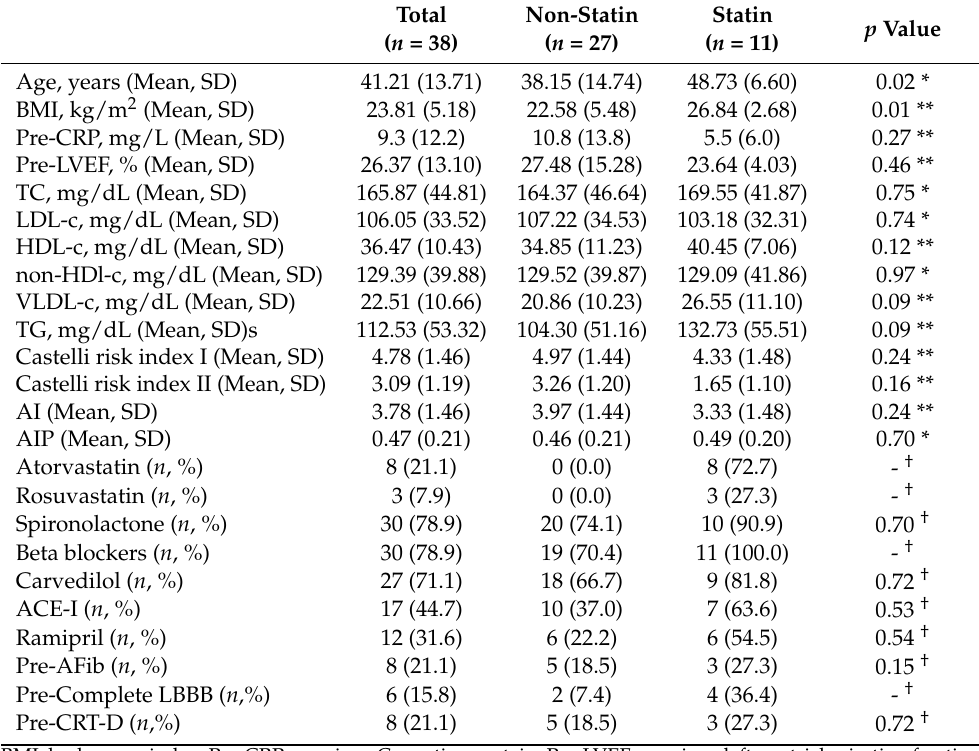
Table 1. Baseline patient